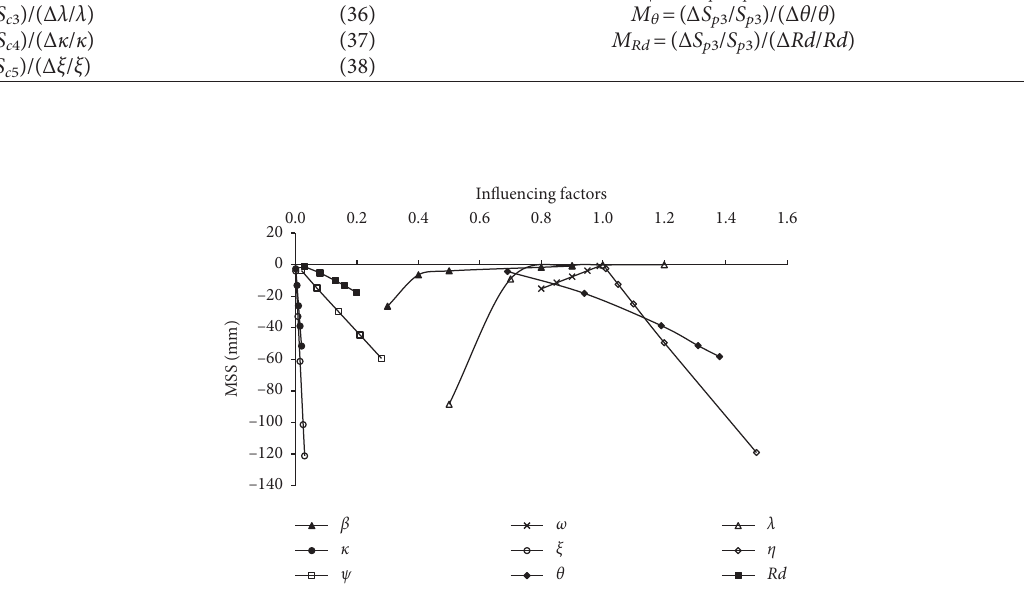
Figure 7: MSS values under different influencing